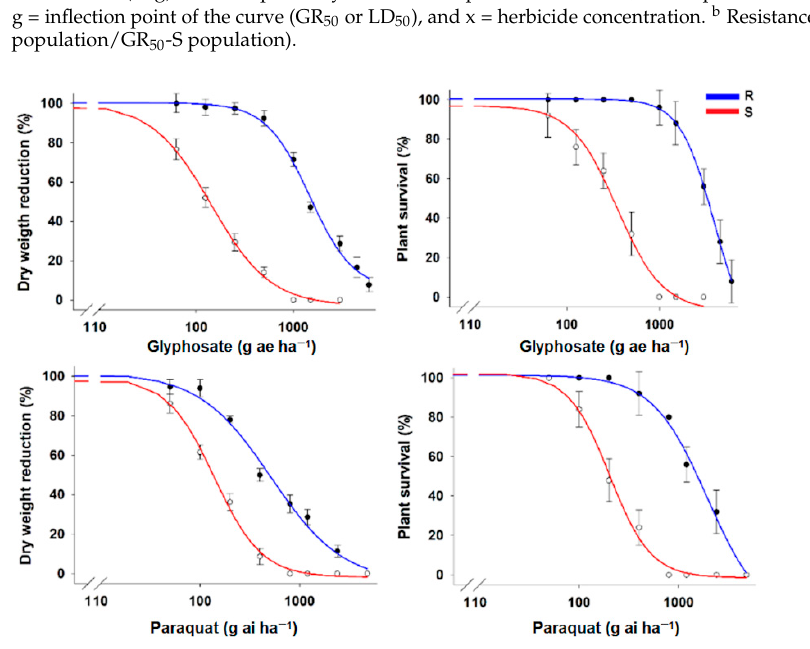
Figure 1. Dose response curves to glyphosate and paraquat on the fresh weight reduction and plant survival rate of susceptible (S) and resistant (R) Eleusine indica populations from Colombia. Vertical bars represent the standard error ( n =